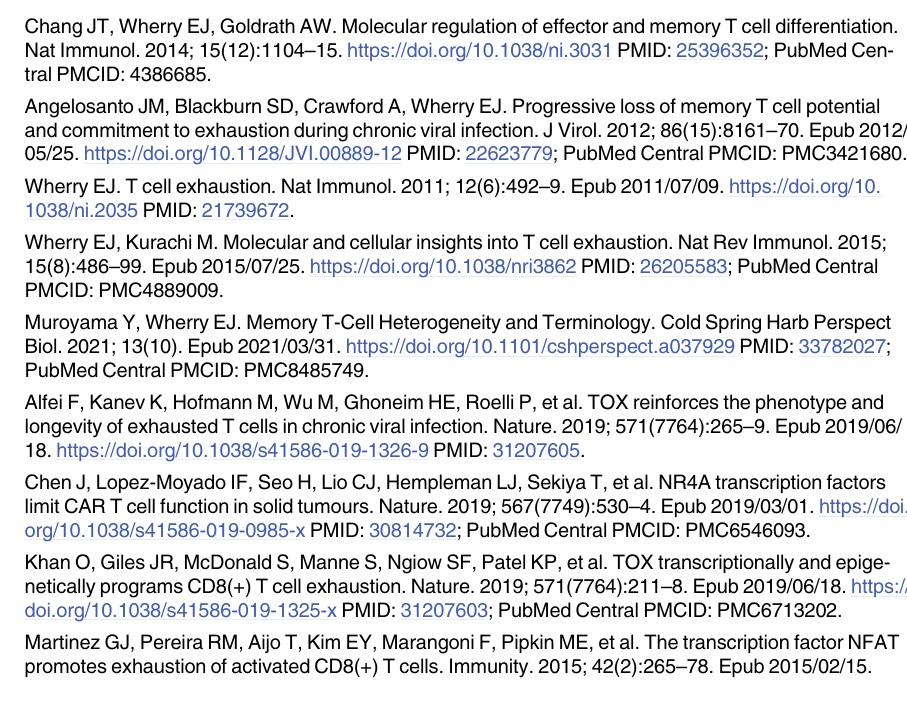
MFI (right) of isotype- (blue) or anti-IFNAR1-treated (red) P14 T cells expressing each mole- cule. Data are shown as mean ± SEM. � p < 0.05, �� p < 0.01, ��� p < 0.0001 (Student’s t test). Data are representative of 2 to 3 independent experiments. The raw data for the panels in this figure are located in S1 Data file. S6A Fig created with BioRender.com. CFSE, carboxyfluores- cein succinimidyl ester; IFN-I, type I interferon; LCMV-Cl13, LCMV-Clone 13; MFI, mean fluorescence intensity.